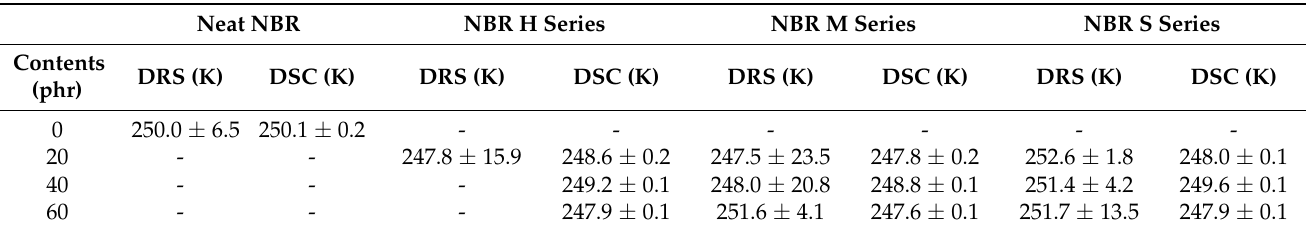
Table 3. Summary of the T g values obtained with DRS and